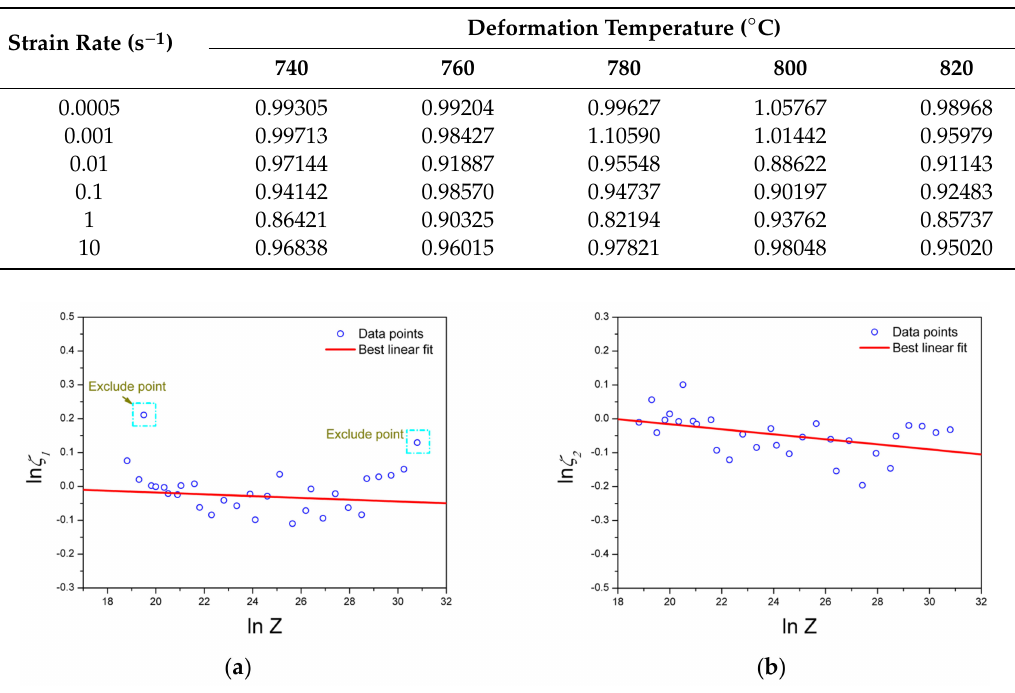
Table 4. The values of the material constant, ζ 2 , under all of the tested specified loading conditions.